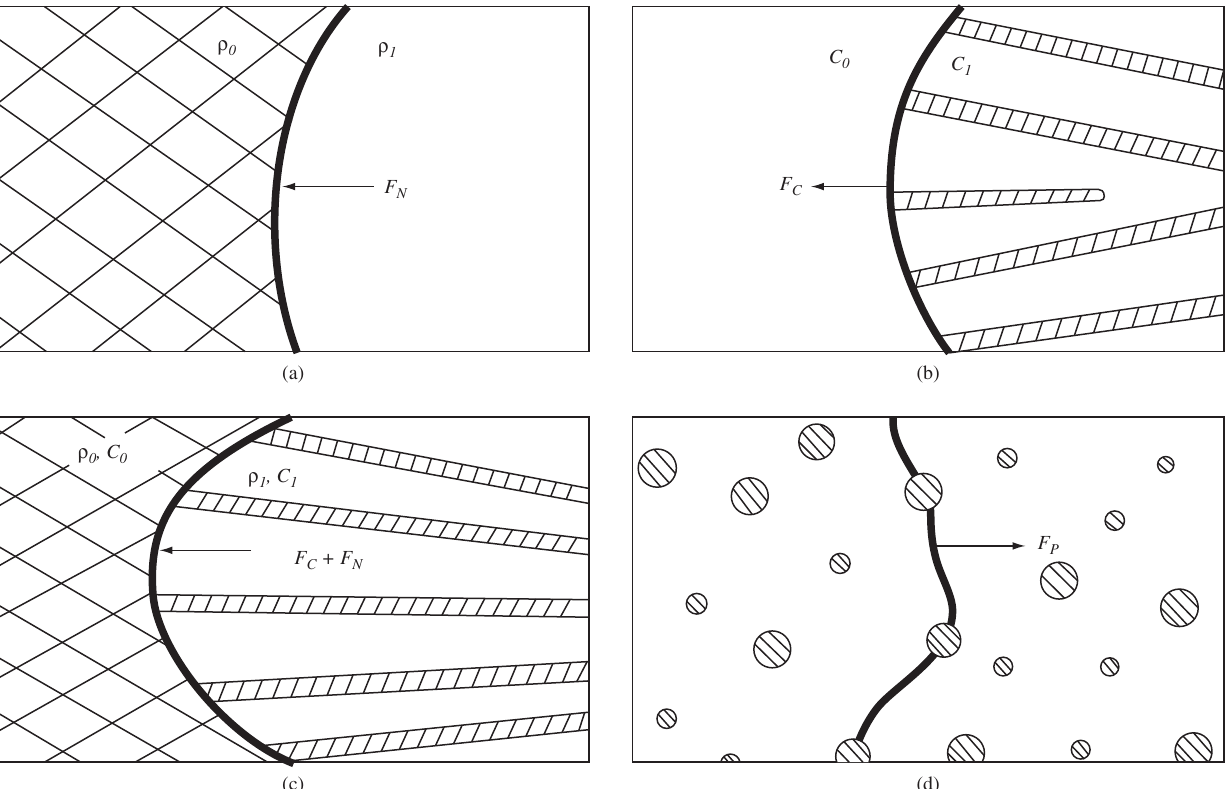
Figure 12. Forces acting at the reaction front. a) Recrystallization: grain boundary is the reaction front, reducing dislocation density from ρ ous precipitation: grain boundary is the reaction front, reducing supersaturation from C to C ; c) Discontinuous precipitation combined with recrystallization. o 1 Dislocation density ρ and supersaturation C reduced to ρ and C ; and d) Dispersed particles exerting retarding force on grain boundary migration 53,103 o o 1 1